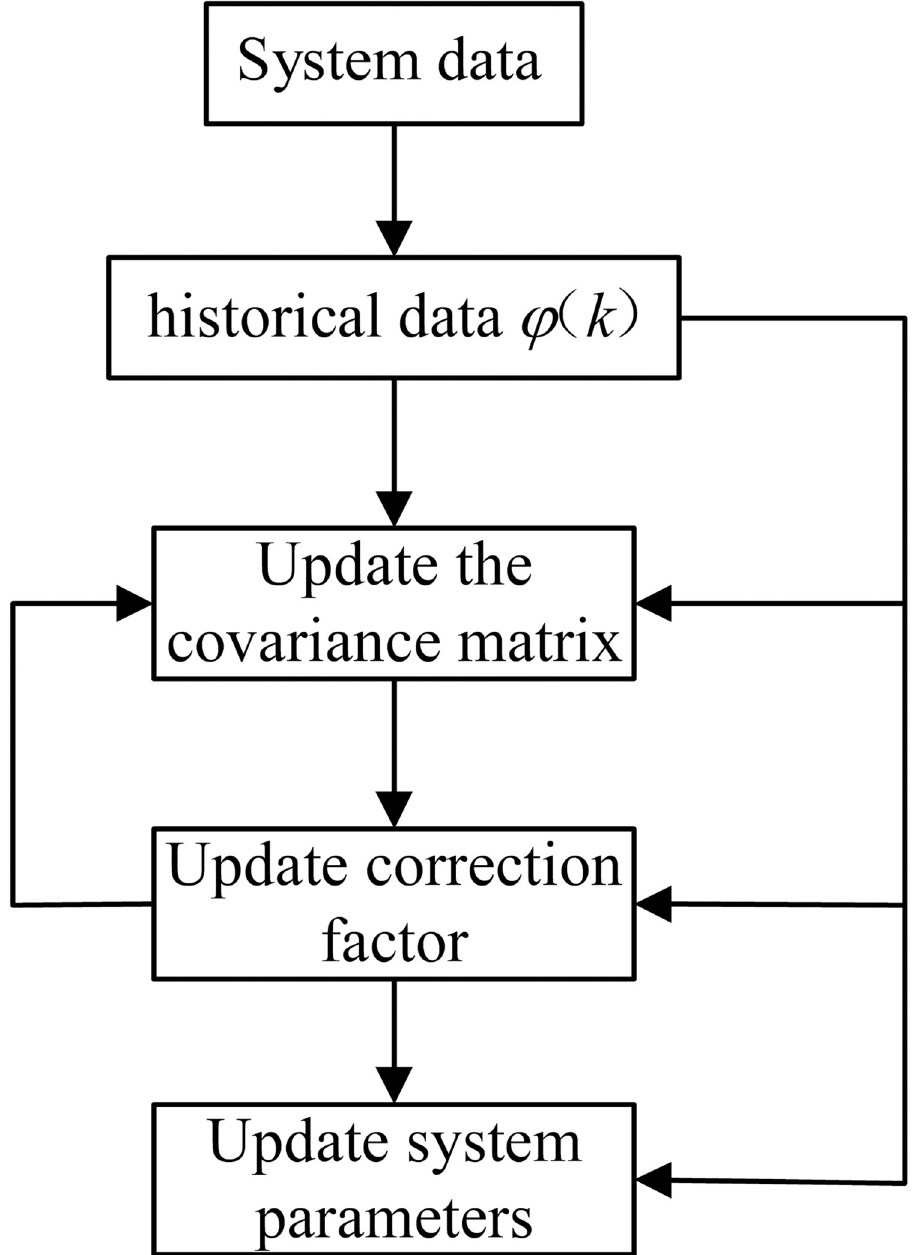
Fig 6. Schematic diagram identification system using the least squares